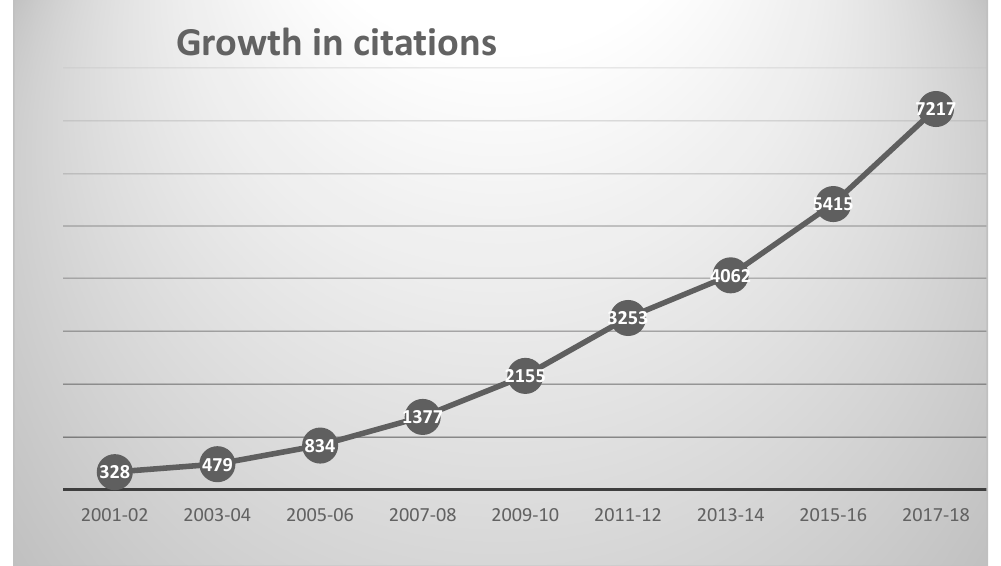
Figure 2. Growth in annual citations to chemoinformatics publications since 2001. Table 4. Chemoinformatics articles attracting the largest numbers of citations.